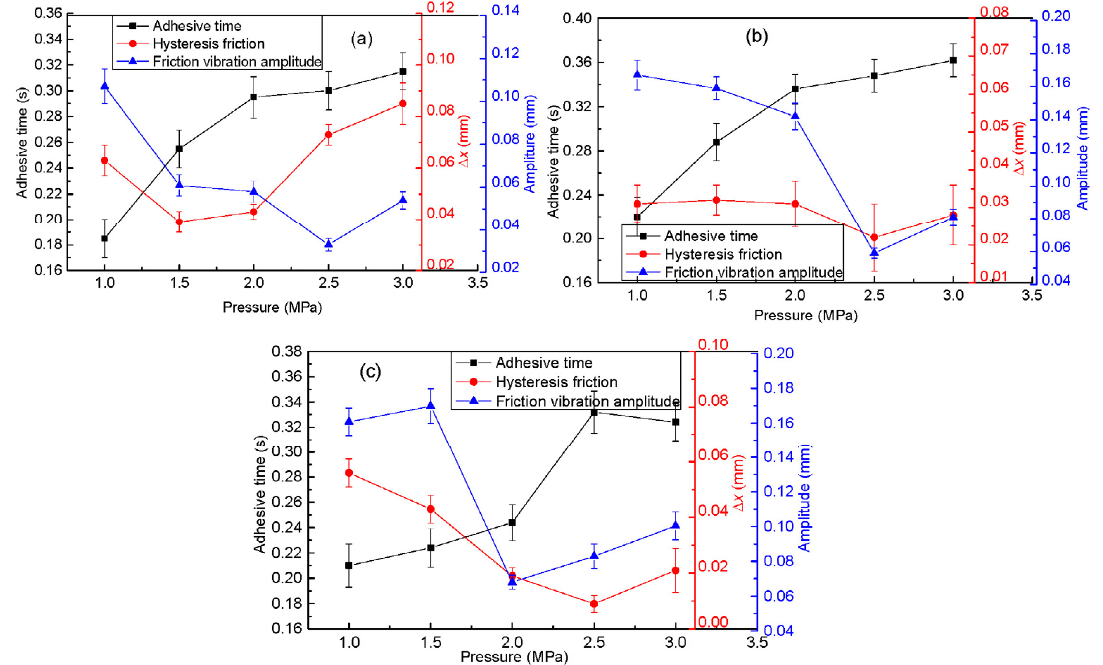
Fig. 16 Relationship between frictional vibration amplitude, adhesive time, and hysteresis friction: (a) K25 lining, (b) G30 lining, and (c) GM-3